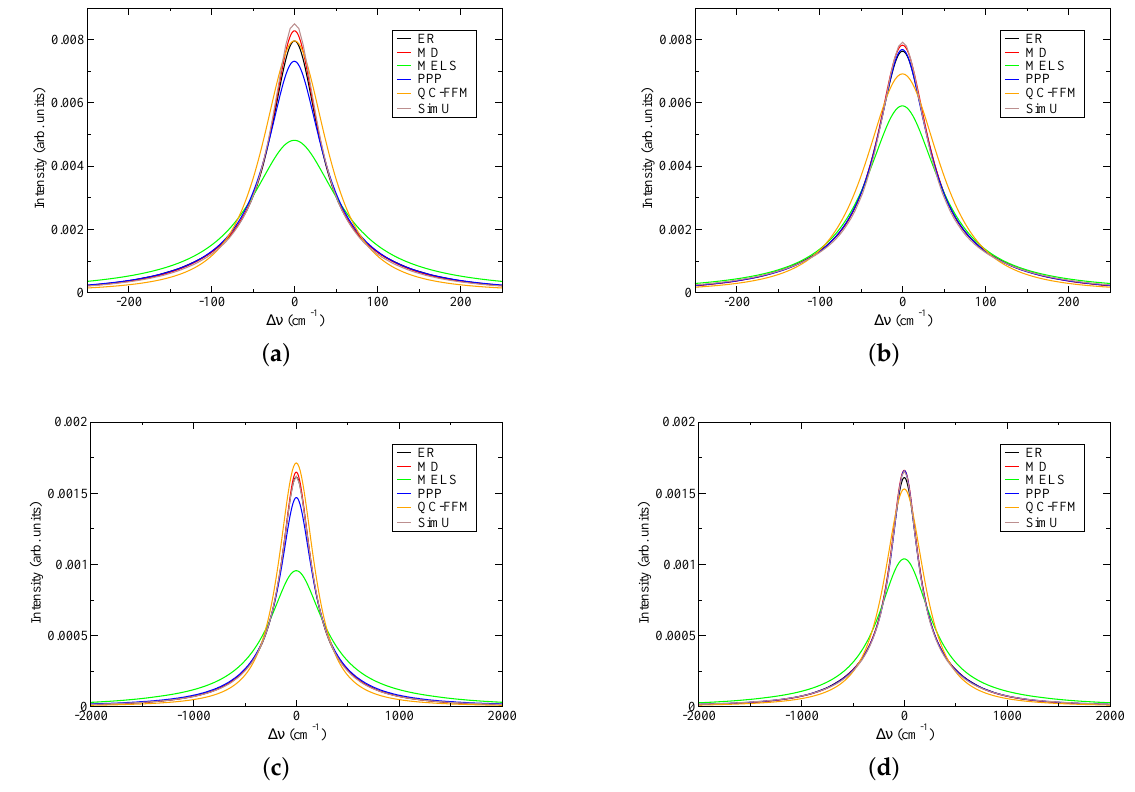
Figure 5. Sub-cases without quenching. Plasma conditions assumed as follows: ( a ) n e = 10 18 cm − 3 and T = 4eV; ( b ) n e = 10 18 cm − 3 and T = 10eV; ( c ) n e = 10 19 cm − 3 and T = 4eV; ( d ) n e = 10 19 cm − 3 and T =